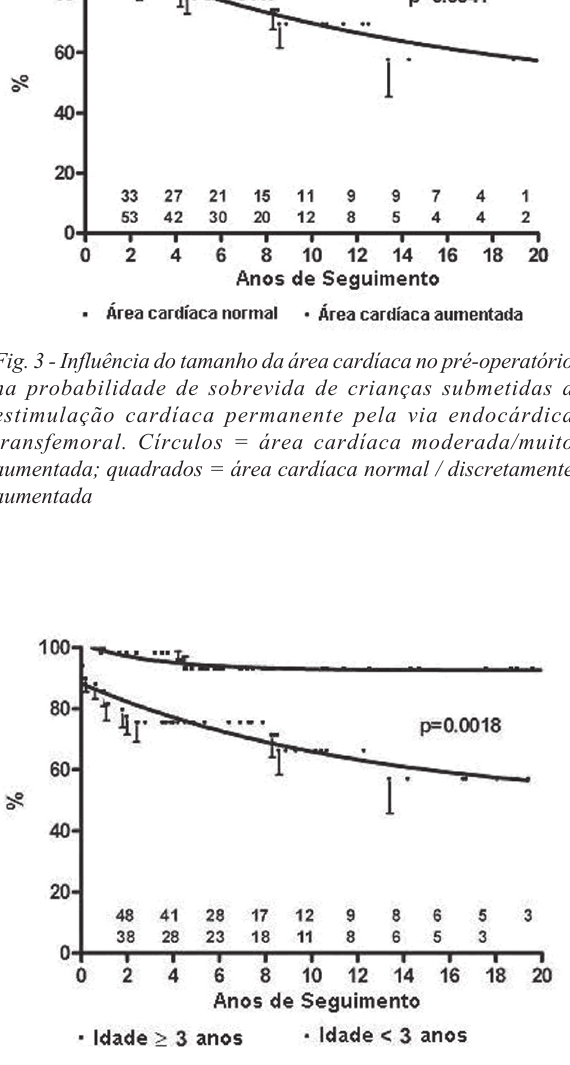
Fig. 4 - Influência da idade no momento do primeiro implante na probabilidade de sobrevida de crianças submetidas à estimulação cardíaca permanente pela via endocárdica transfemoral. Círculos = idade < 3 anos; quadrados = idade = 3